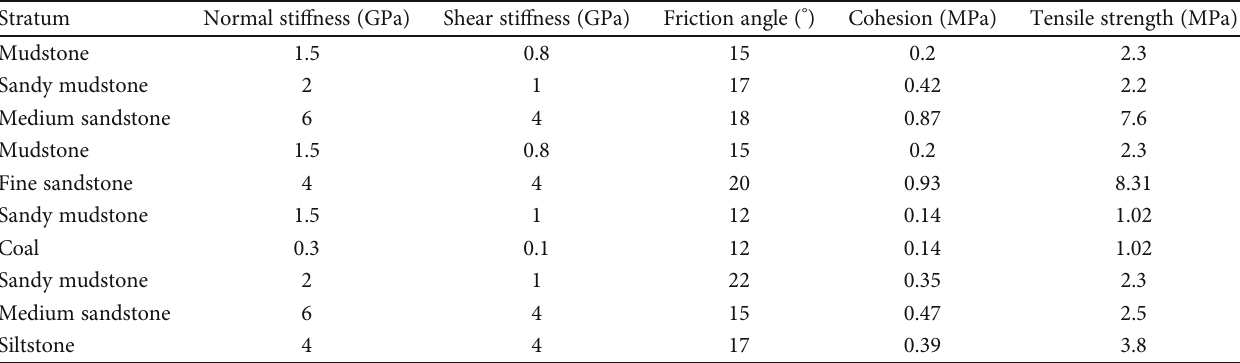
Table 2: Numerical analysis of joint